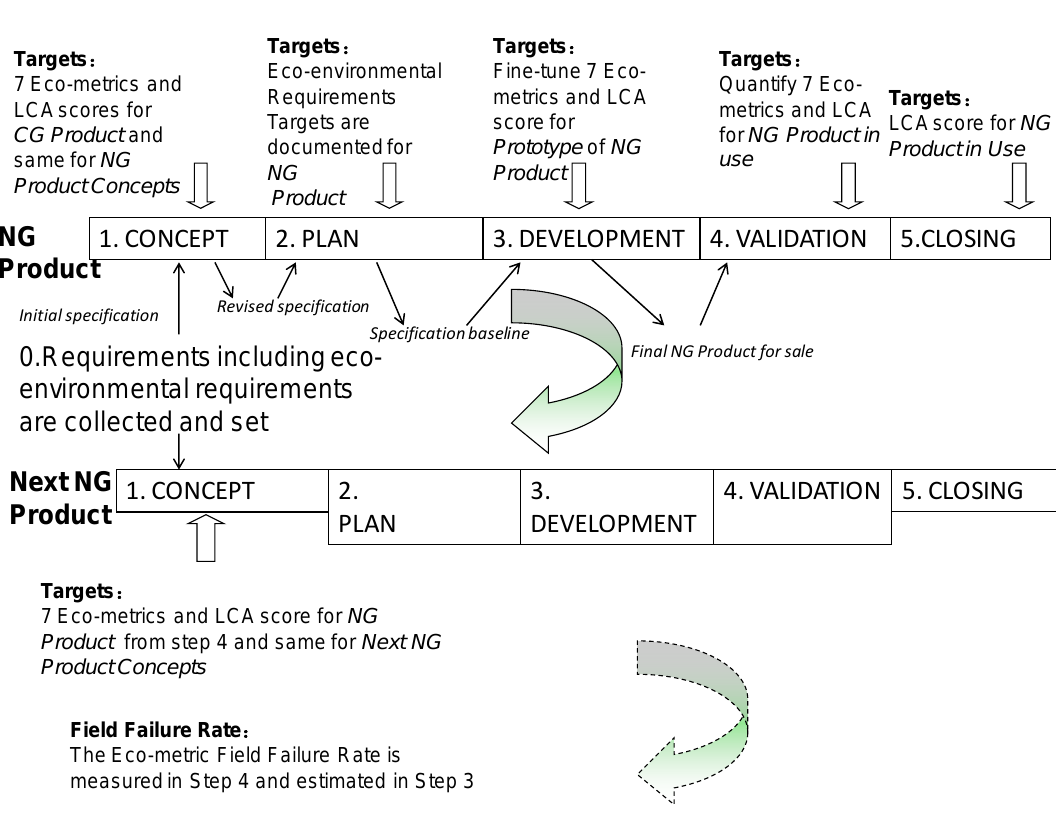
Figure 1. Steps of product development and the actions and targets for the eco-design method EcoSmarT.